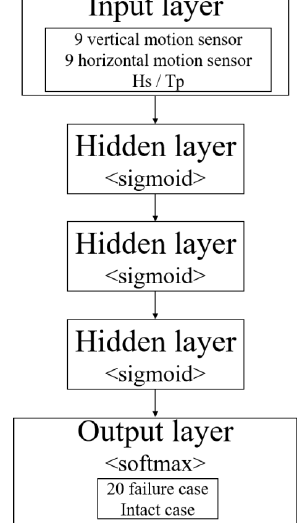
Figure 4. Layout of the present neural network model.